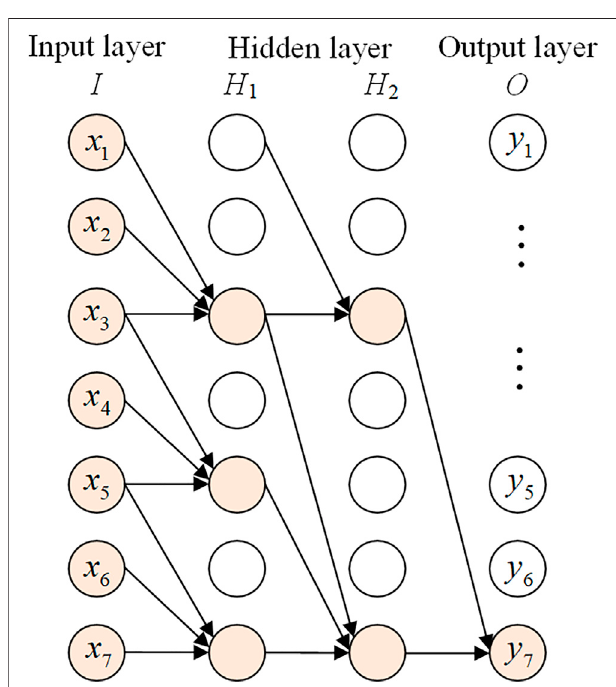
FIGURE 2 | Dilated convolution